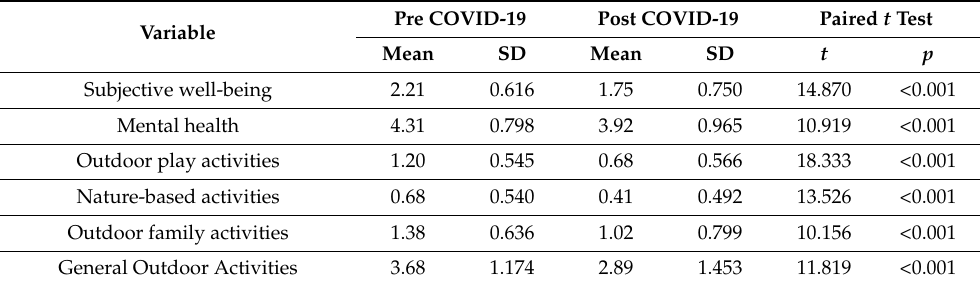
Table 4. Paired sample t-tests for pre and post COVID-19 pandemic subjective well-being scores, mental health scores, and outdoor activity scores.